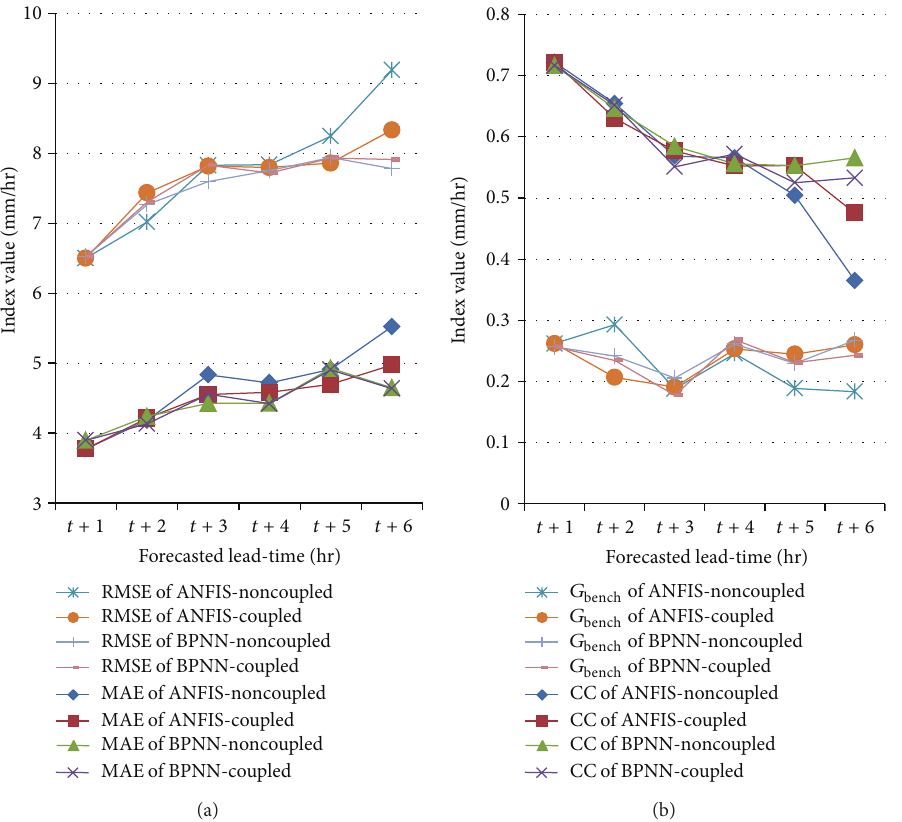
Figure 14: The testing index values of the coupled and noncoupled models at Yu-Feng station: (a) MAE and RMSE; (b) CC and 𝐺